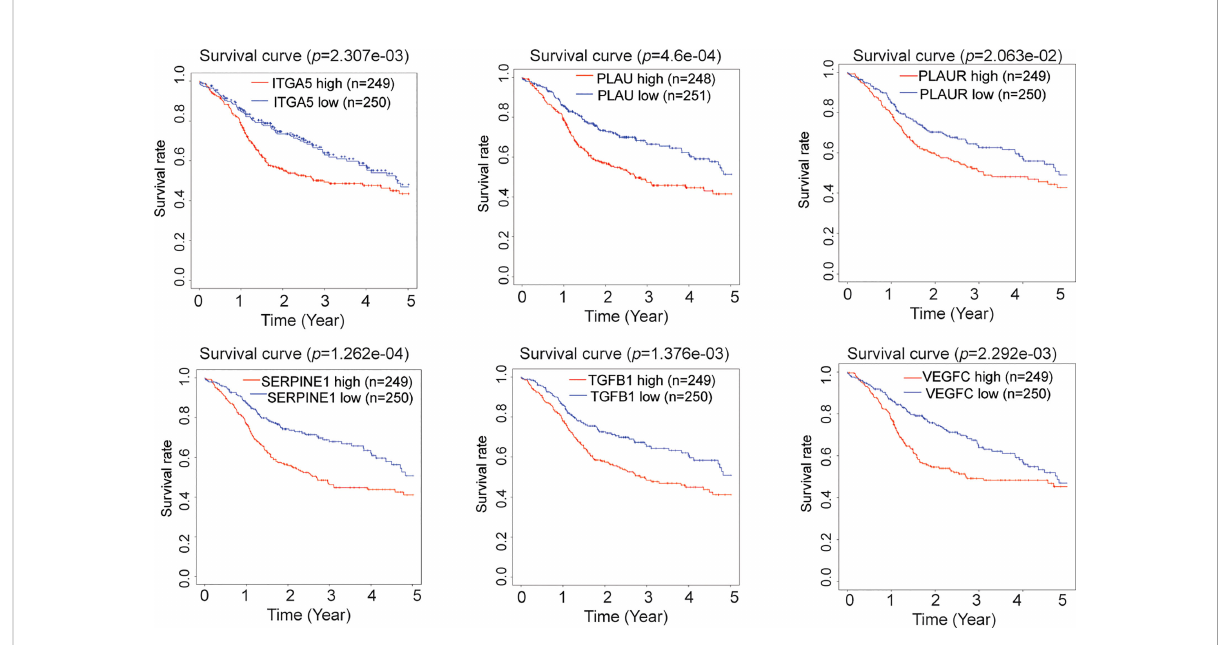
FIGURE 4 Prognostic value of the biomarkers for head and neck squamous cell carcinoma (HNSCC). Kaplan – Meier survival curves of patients with HNSCC based on the high or low expression levels (above or below median expression) of ITGA5 , PLAU , PLAUR , SERPINE1 , TGFB1 , and VEGFC